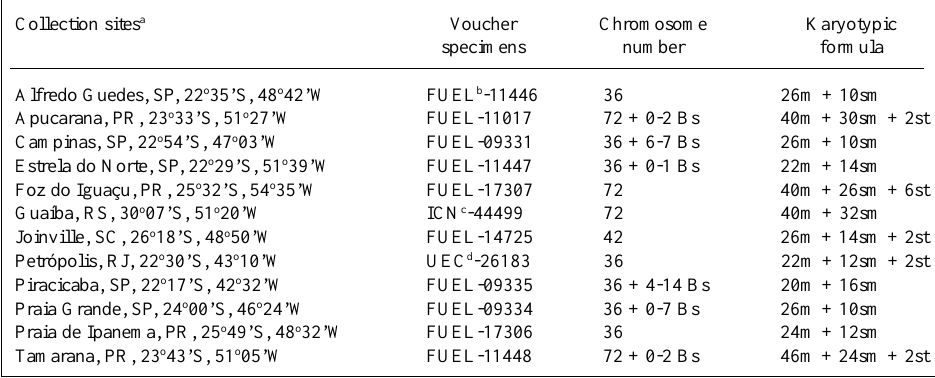
Table I - Sites of origin, collection number, chromosome number, and karyotypic formula of 12 populations of Mikania micrantha. Collection sites